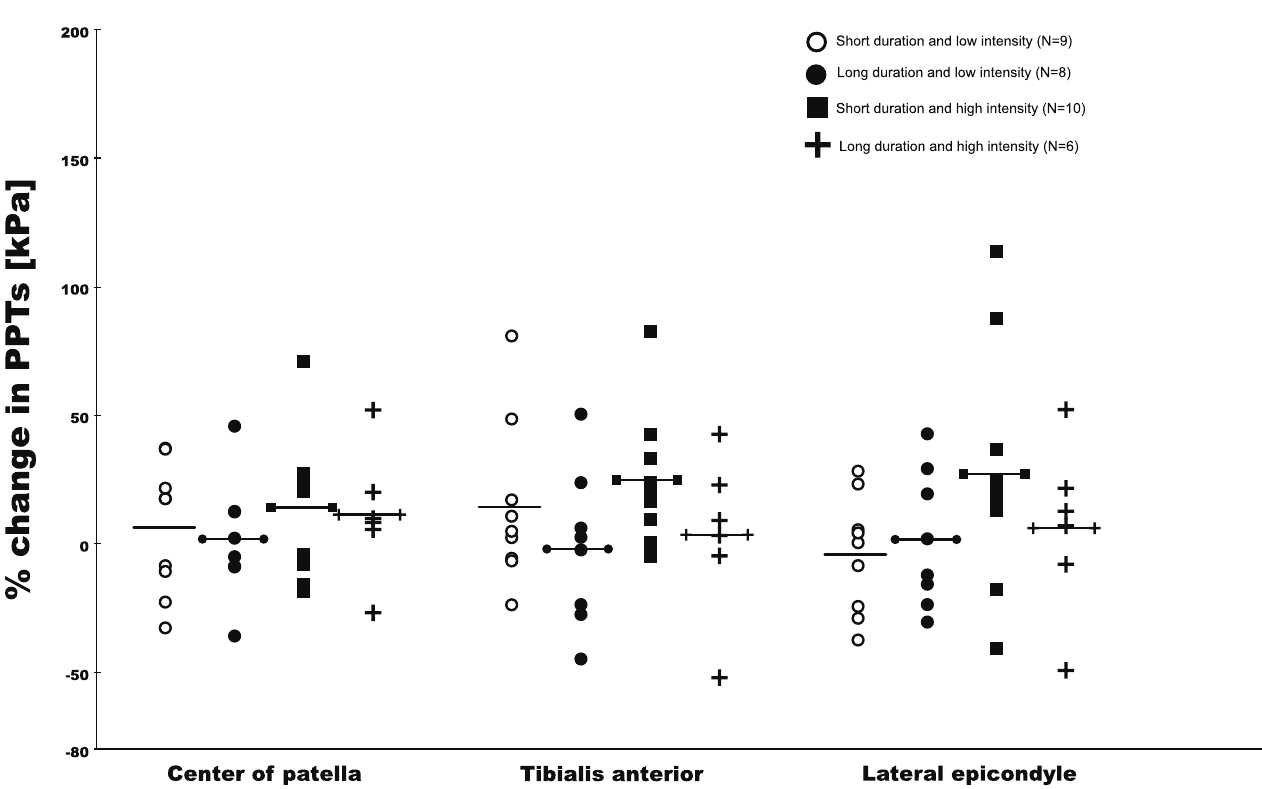
Fig 3. Change in PPTs after the conditioning stimulus at the three test sites split into four groups based on a median split of pain intensity and duration of symptoms among patients with PFP.